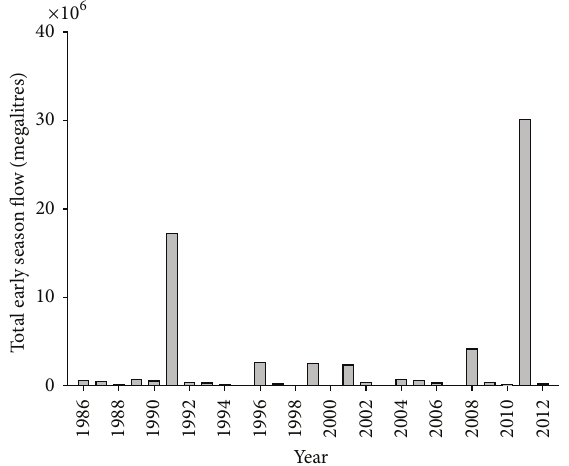
Figure5:Total“earlyseasonflow”inmegalitresfortheFitzroyRiver measured at “The Gap.” Early season flow reflects measurement of total water flow from 1 November to 28 February, corresponding to the putative COTS spawning season. Thus the bar in the figure labelled 2012 represents total flow measured at “The Gap” between November 2011 and February